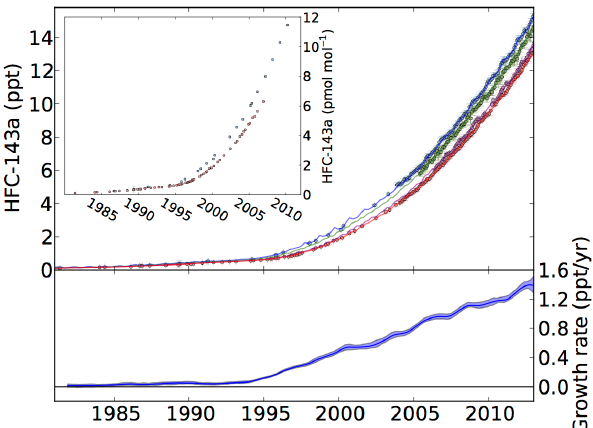
Figure 3. Semi-hemispheric monthly average HFC-143a mole frac- tions (30–90 ◦ N: blue; 0–30 ◦ N: green; 30–0 ◦ S: purple; 90–30 ◦ S: red). Averaged observations are shown as data points with error bars. The more sparse circles represent NH and SH air archive sam- ples, and are highlighted in the inset box. The solid trend lines were calculated using a 12-box model with emissions from the inversion as input. The lower plot shows the annual running mean global mole fraction growth